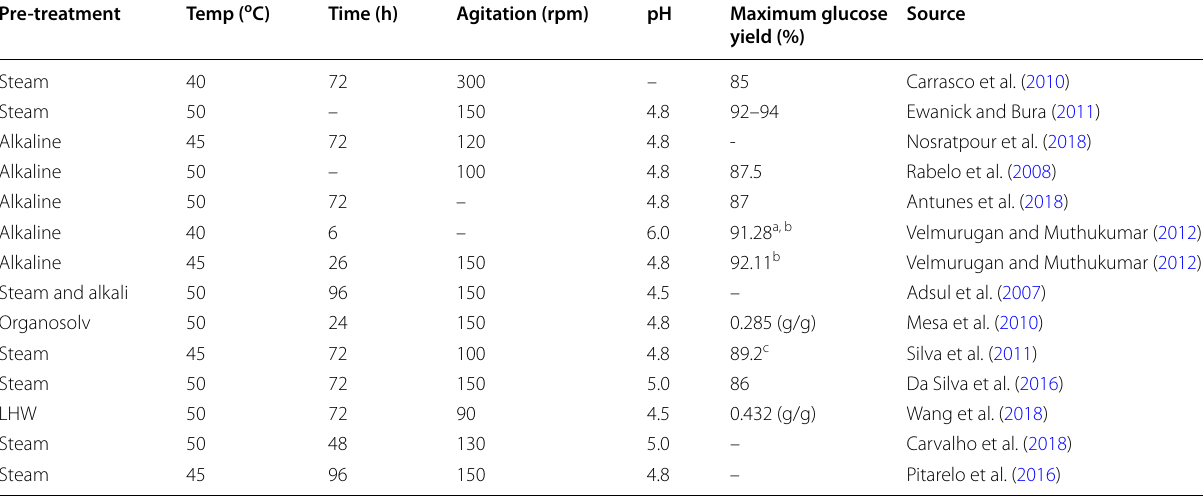
a Yield of ethanol from final fermentation, b ultrasound-assisted process, c cellulose conversion